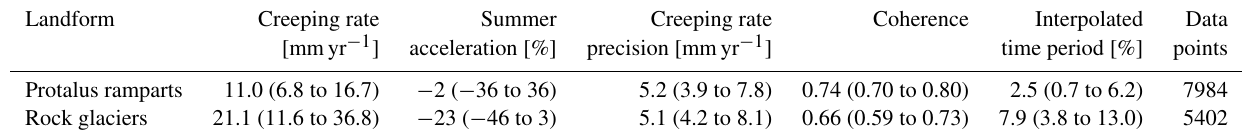
Table 4. Summary of InSAR-derived creeping rates for the periglacial landforms. The values represent the median of all data points over the entire observation period (2015–2018) on the respective landform. Uncertainty is given by the interquartile range in round brackets. The percentage of interpolated time periods describes how many interferograms are incoherent and therefore require interpolation with the ISBAS algorithm.